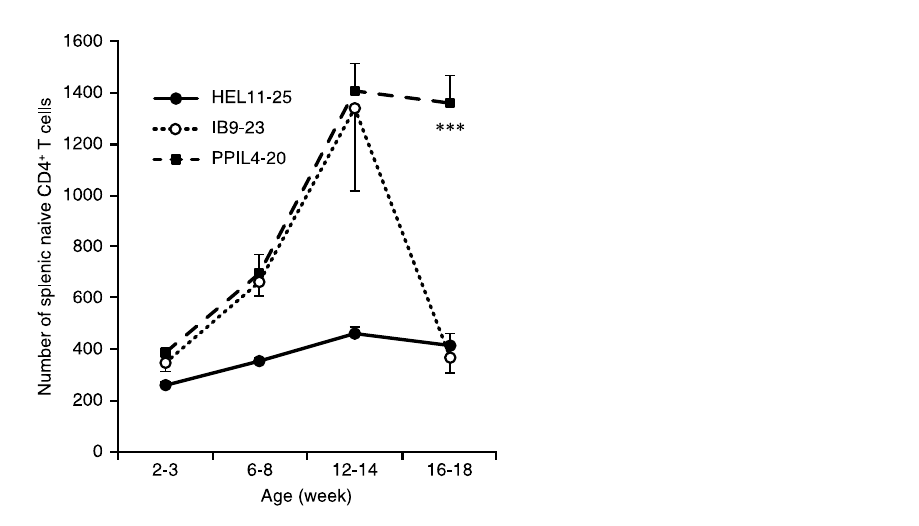
Figure 2. A large pool of naive CD4 + T cells recognizing PPI L4-20 is available in near-diabetic 16–18 weeks old NOD mice. Splenic mononuclear cells were isolated from female NOD mice at the indicated ages. The CD4 + T cells were purified by negative selection as described in Methods and stained with FITC-anti-CD4, APC-anti-CD25, and a PE-labeled I-A g7 tetramer loaded with the indicated peptide. The frequency of naïve CD4 + CD25 - PE + T cells was determined by flow cytometry. The numbers of naive CD4 + T cells were calculated based on the total numbers of CD4 + T cells in each mouse. Data are expressed as the mean ± SD of each group ( n = 8) of mice from at least three separate experiments. *** p < 0.001 for PPI L4-20 vs. insulin B 9-23 by Student’s t -test.